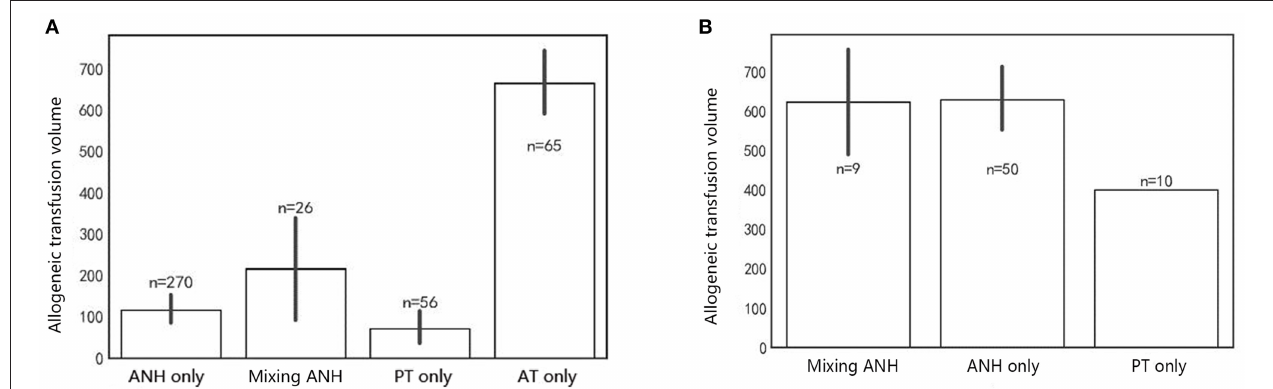
FIGURE 2 | Allogeneic blood transfusion volume of different situations. (A) Total allogeneic blood consumption across different modes. (B) Combined allogeneic blood consumption across different modes. Bar represents mean ± SD. ANH, Acute normovolemic hemodilution; Mixing ANH, mixing acute normovolemic hemodilution with predonation; PT, predonated transfusion; AT, allogeneic transfusion.